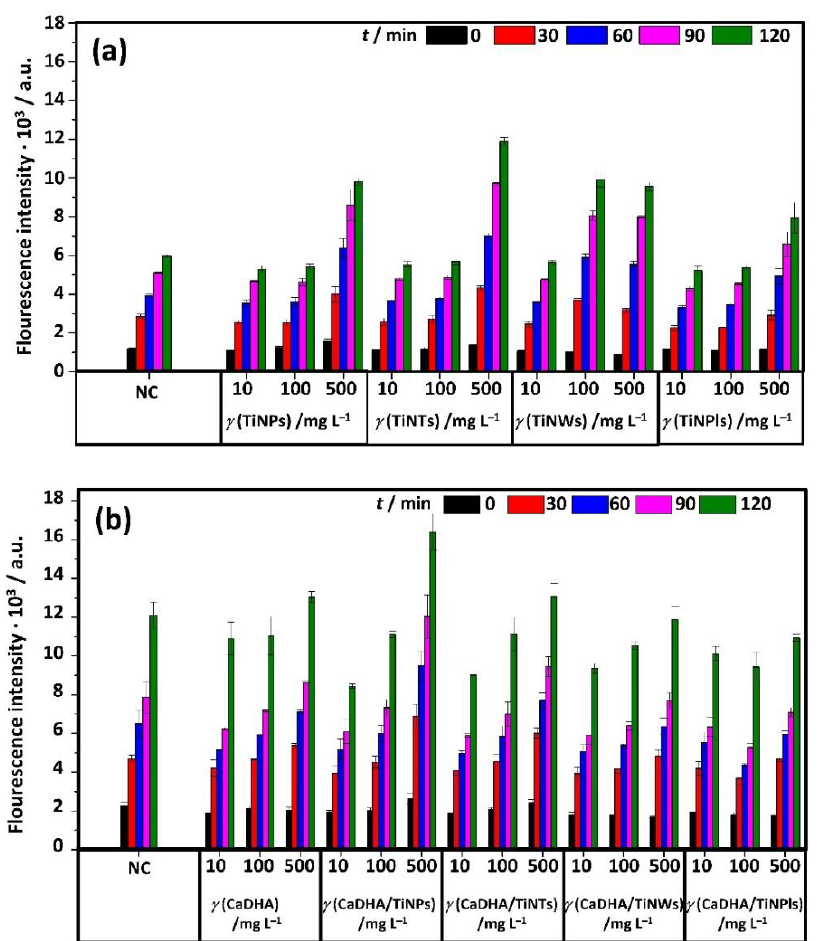
Figure 9. The intensity of DCF fluorescence after incubation in PBS with different concentrations (10, 100, and 500 mg L − 1 ) of ( a ) TiO 2 nanoparticles (TiNPs), titanate nanotubes (TiNTs), TiO 2 nanowires (TiNWs), and TiO 2 nanoplates (TiNPls), and ( b ) precipitates formed after 60 min reaction time in the control system (calcium deficient hydroxyapatite, CaDHA) and in the presence of 100 mg L − 1 TiO 2 nanoparticles (CaDHA/TiNPs), nanotubes (CaDHA/TiNTs), nanowires (CaDHA/TiNWs), and nanoplates (CaDHA/TiNPls).